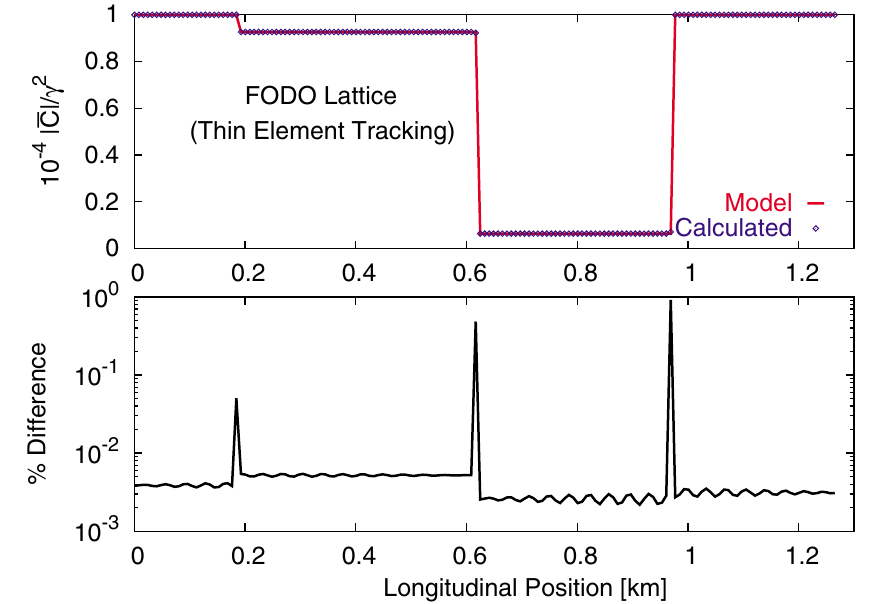
FIG. 4. (Color) Top: Comparison of j C j =(cid:20) 2 between MAD-X model and SVD computed values from tracking data. Bottom: Difference between model and calculated values of j C j =(cid:20) 2 . Horizontal and vertical tunes are Q